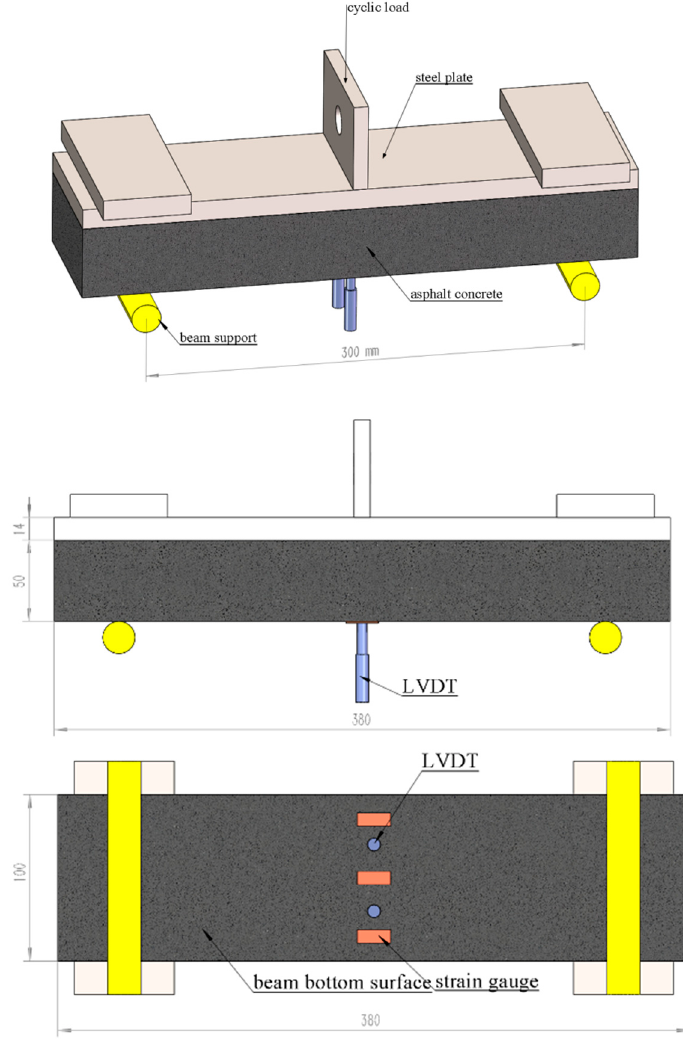
Figure 2. Schematic illustration of fatigue test for steel deck–asphalt pavement beam. Based on the reference of similar tests in China and abroad, the load mode without intermittent sine wave was decided to be used for loading, as shown in Figure 3, with the loading frequency set as 10 Hz.